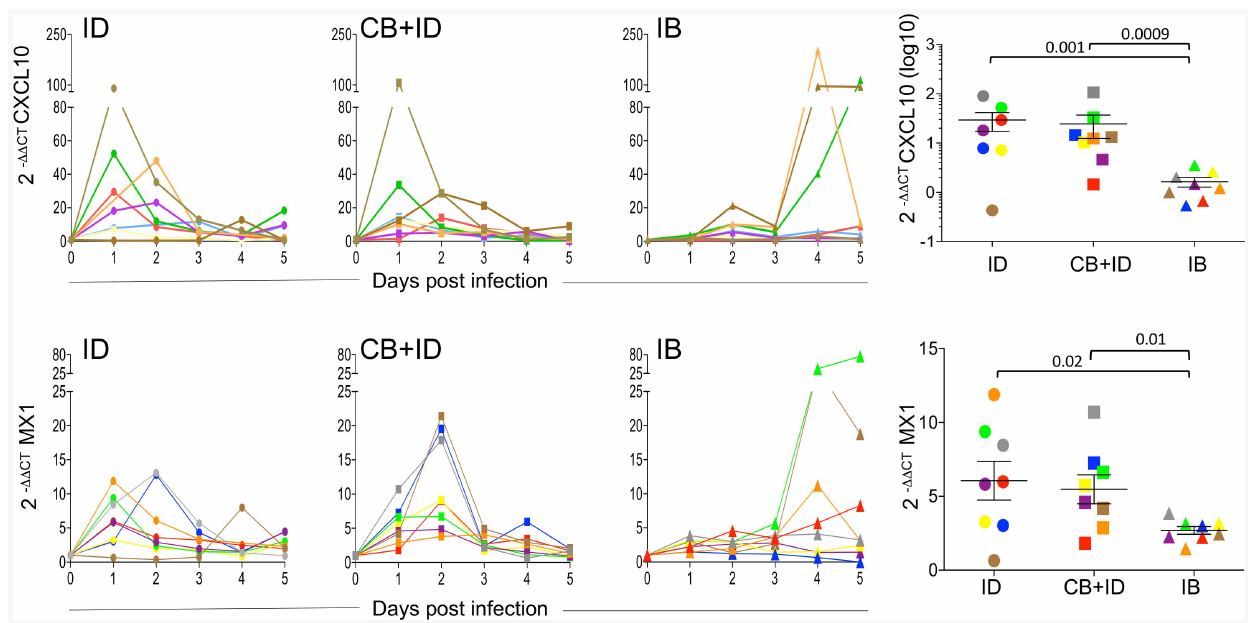
Figure 4. IFN- induced gene expression in blood cells is delayed in C.nubeculosous- infected sheep. Total RNA was extracted from blood cells of each sheep from 0–5 dpi. qPCR was performed on reverse transcribed RNA using the primers for CXCL10 and MX1 genes detailed in Table S3. The 2 2 DD CT method was used to calculate the cytokine gene expression relatively the T0 time point level using the ribosomal RPS24 RNA as an internal control. The blood cells from control and control CB group did not show any induction of CXCL10 and MX1 gene expression during the observation period (not shown). The same color and shape symbol are used as in Fig. 1. Statistical comparisons between 2 groups were done with a Mann-Whitney U test and the p values are reported to show significance.